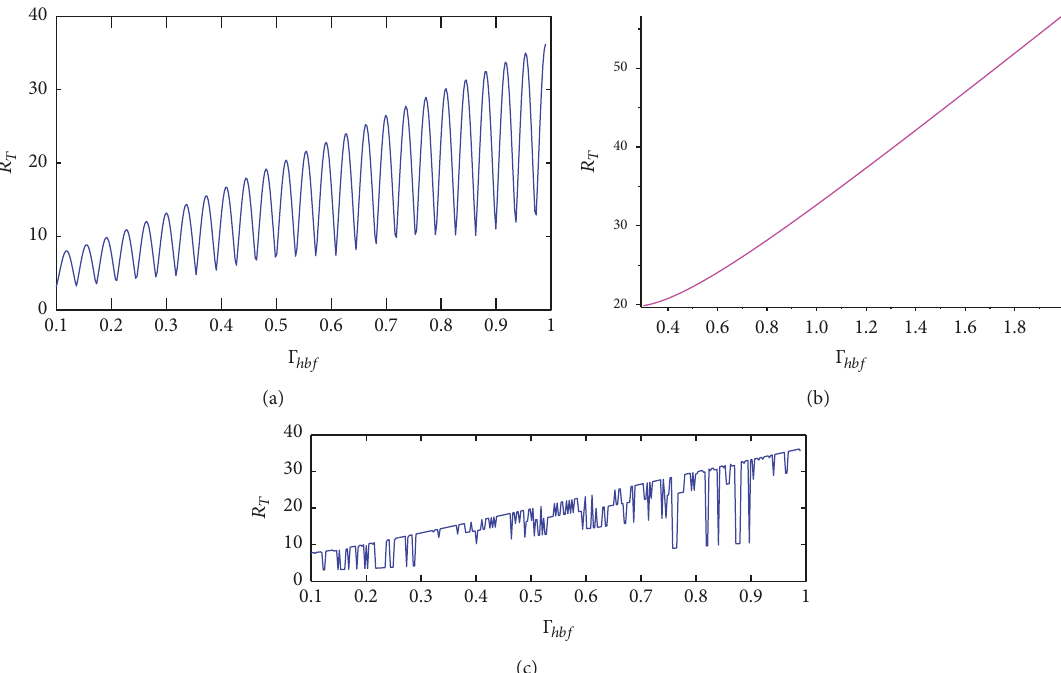
Figure 8: The effect of increased infection rate to fleas from the infectious human beings ( 𝐼 𝐻𝐵 ) on the periodic reproduction number.